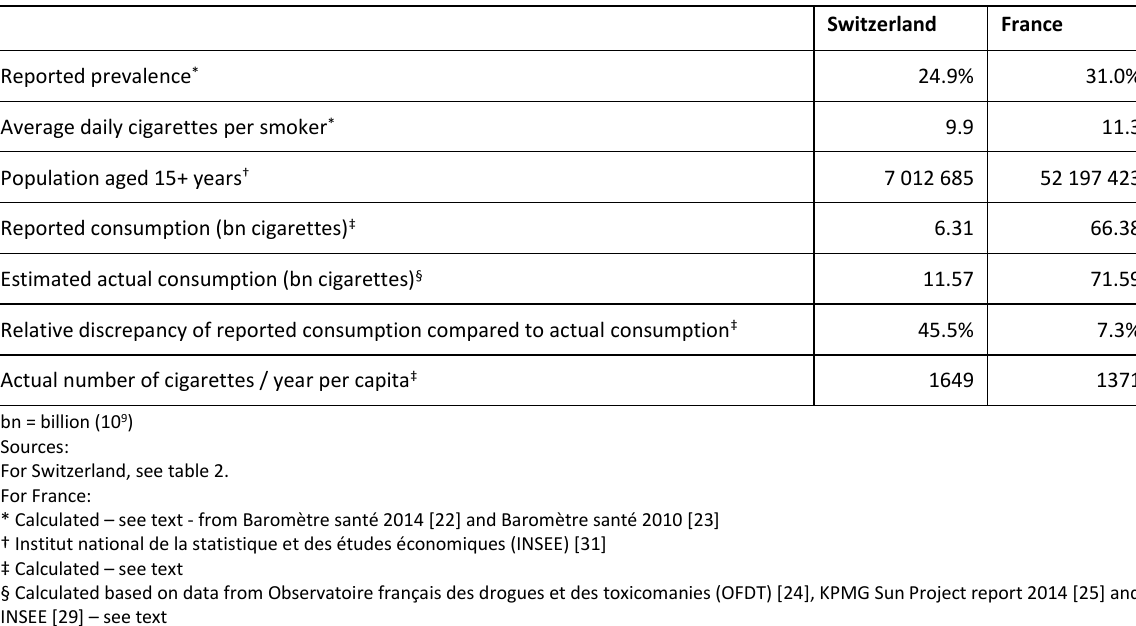
Table 3: Comparison of Switzerland and France with respect to relevant cigarette smoking variables for the year